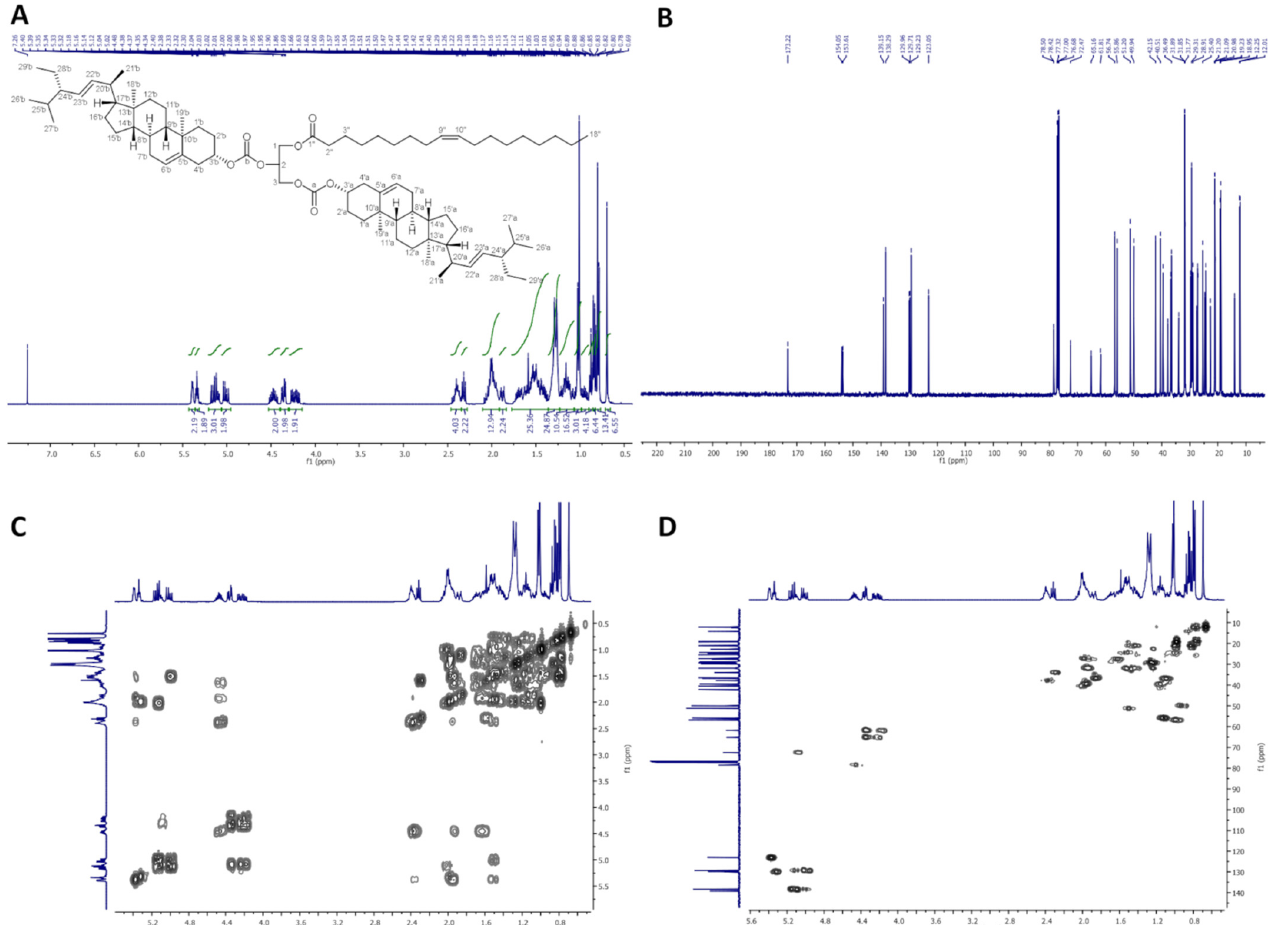
Figure 5. NMR spectra of dStigC-OA: ( A ) 1 H-NMR (400 MHz, CDCl 3 ), ( B ) 13 C-NMR (100 MHz, CDCl 3 ), ( C ) COSY and ( D ) HMQC.